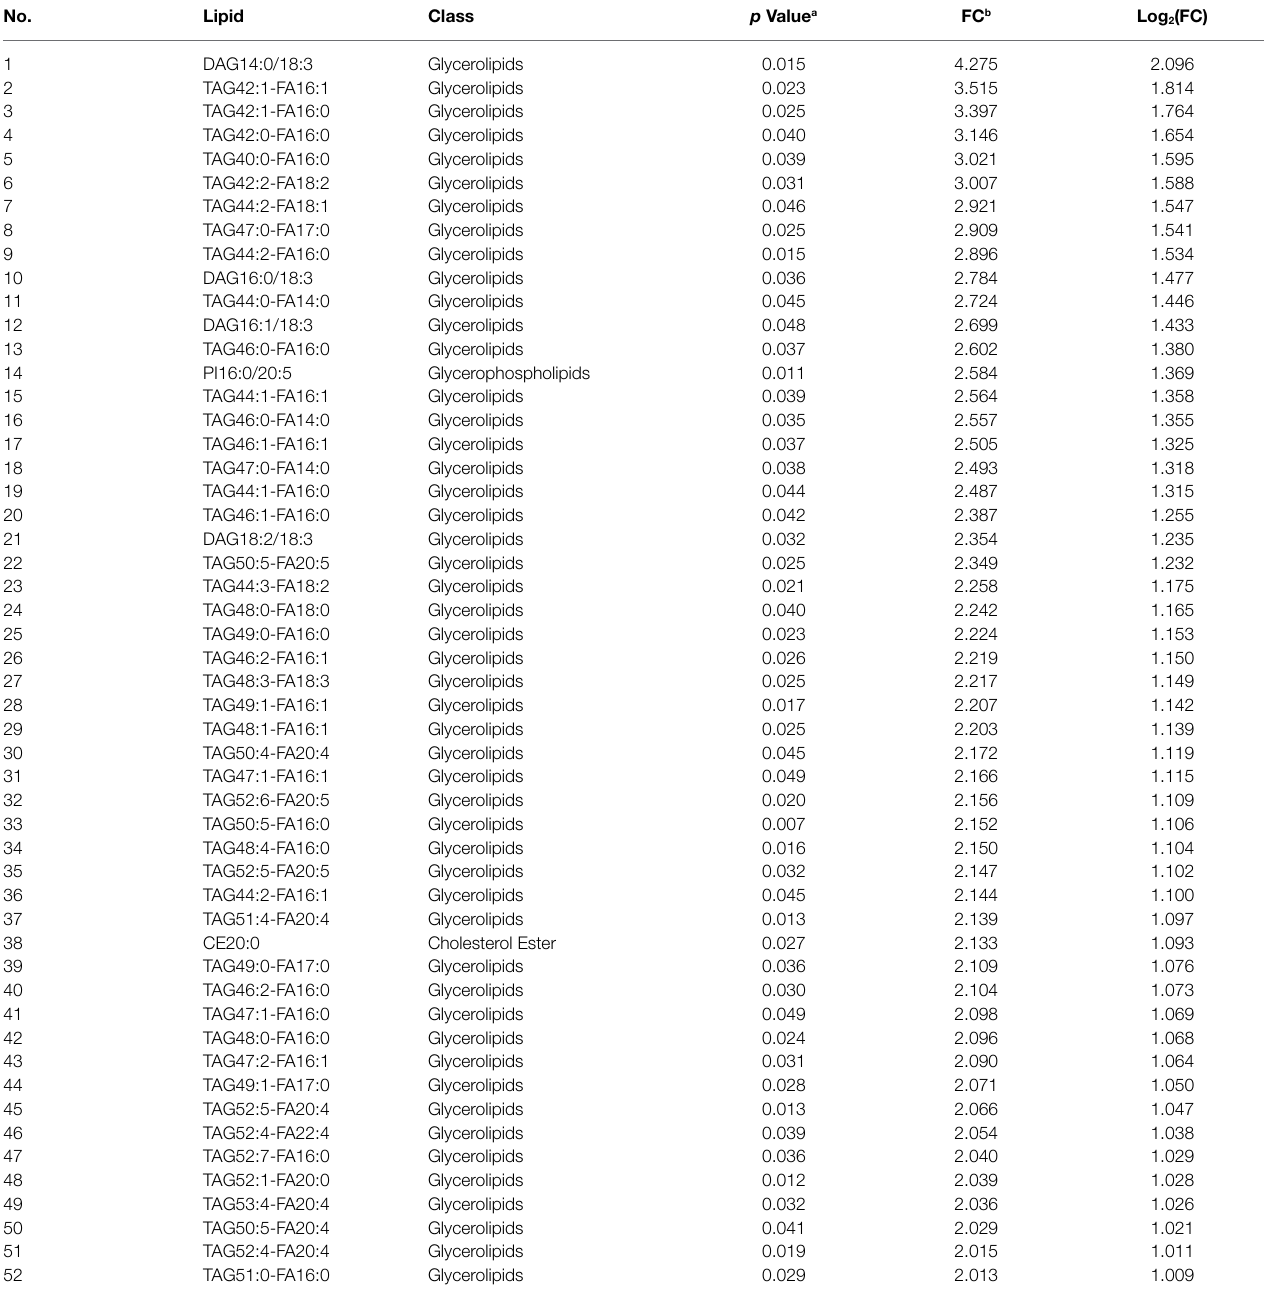
TABLE 4 | Lipids with different levels by EBV VCA-IgA titers among NPC patients. No. Lipid Class p Value a FC b Log 2 (FC)